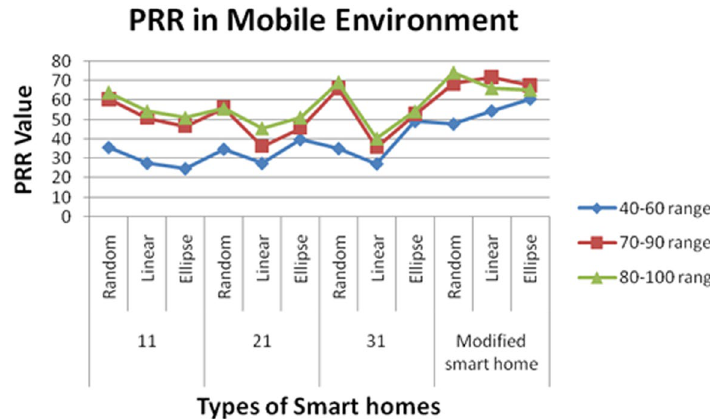
Fig. 21 PRR in mobile environment